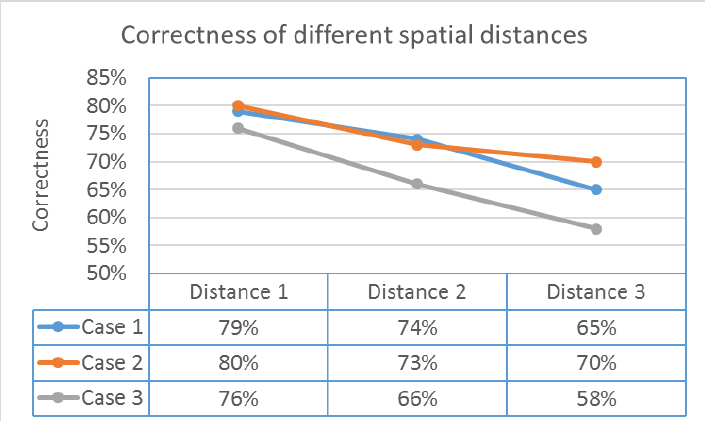
Figure 8. The correctness of different spatial distances.